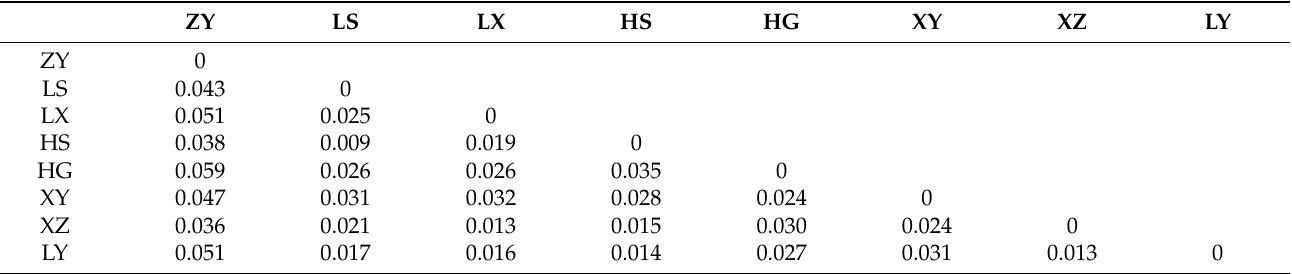
Table 6. Pairwise genetic distances between T. sebifera